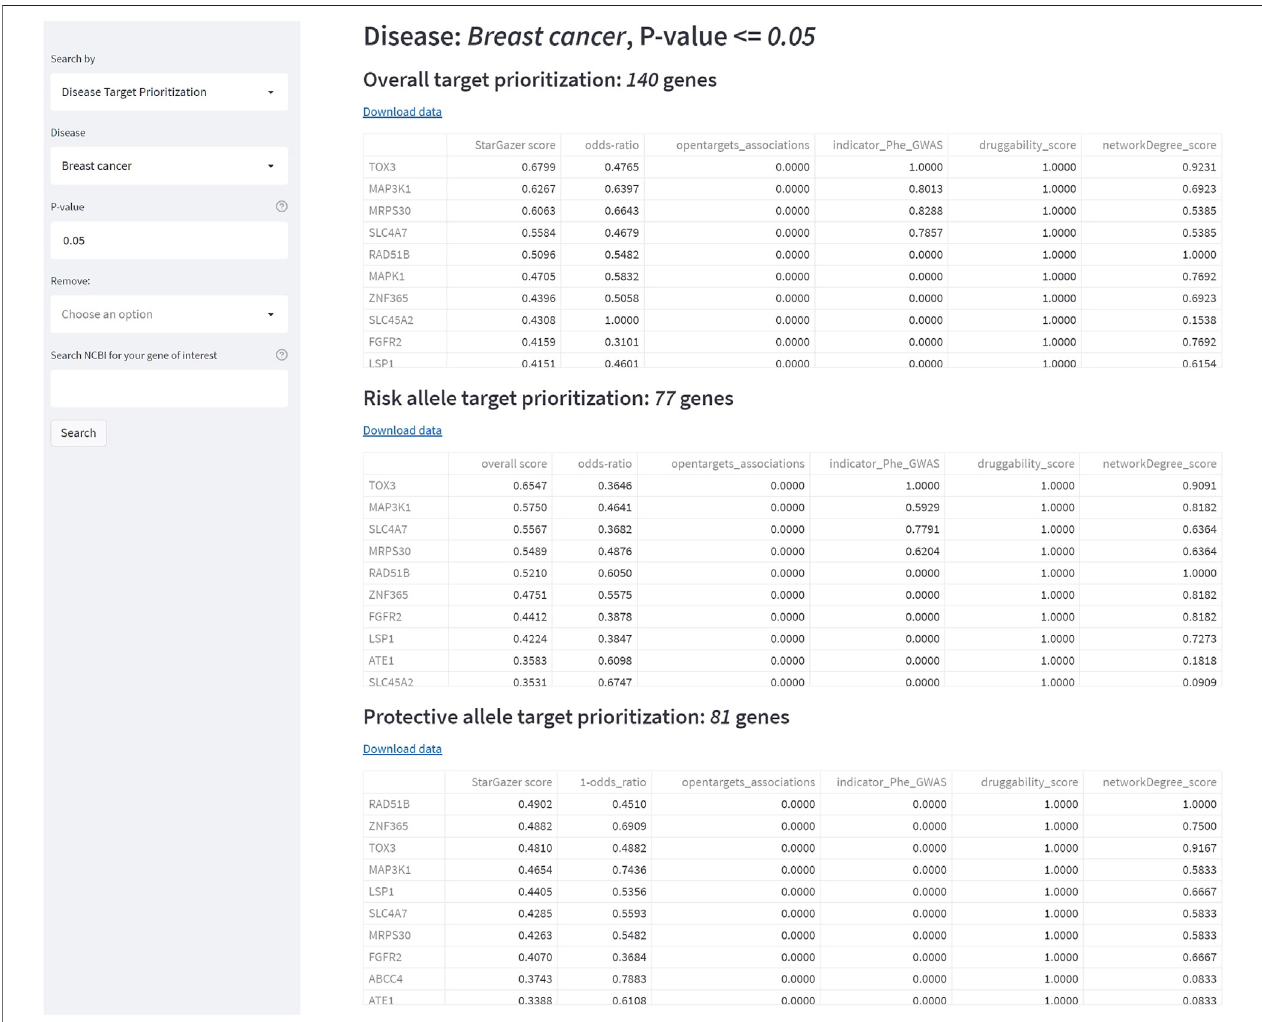
FIGURE6 | TheStarGazer interface after searching “ Breast cancer ” in Disease Target Prioritization mode. At p = 0.05, 140genesare returned tohave association with breast cancer. Genes are ranked in StarGazer score, which describes how suitable a gene is for drug repositioning. The subsequent fi ve columns are the individual scores of the fi ve features extracted from all of the data that contribute to the StarGazer score. Data are separated into all alleles, risk alleles, then protective alleles, and can be downloaded as csv fi les.